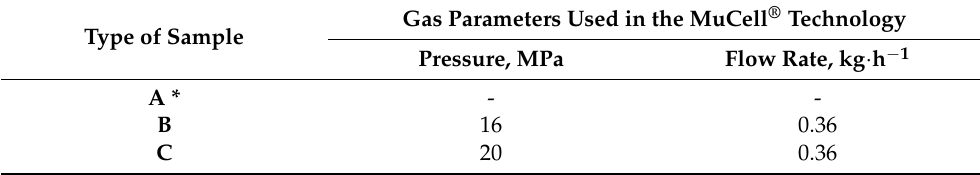
Table 2. Gas parameters used during foam parts